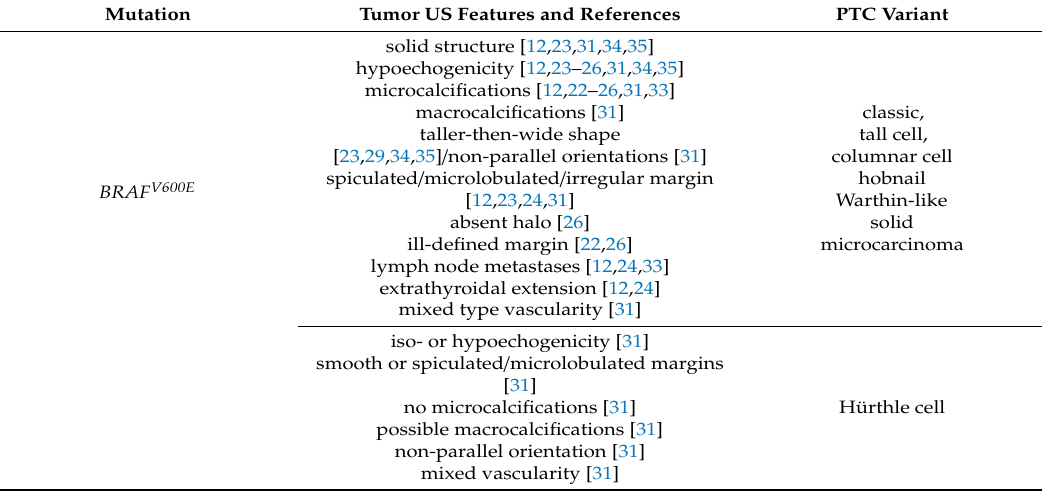
Table 1. Correlations between genetic drivers and sonographic findings in PTC, with respect to the specific PTC